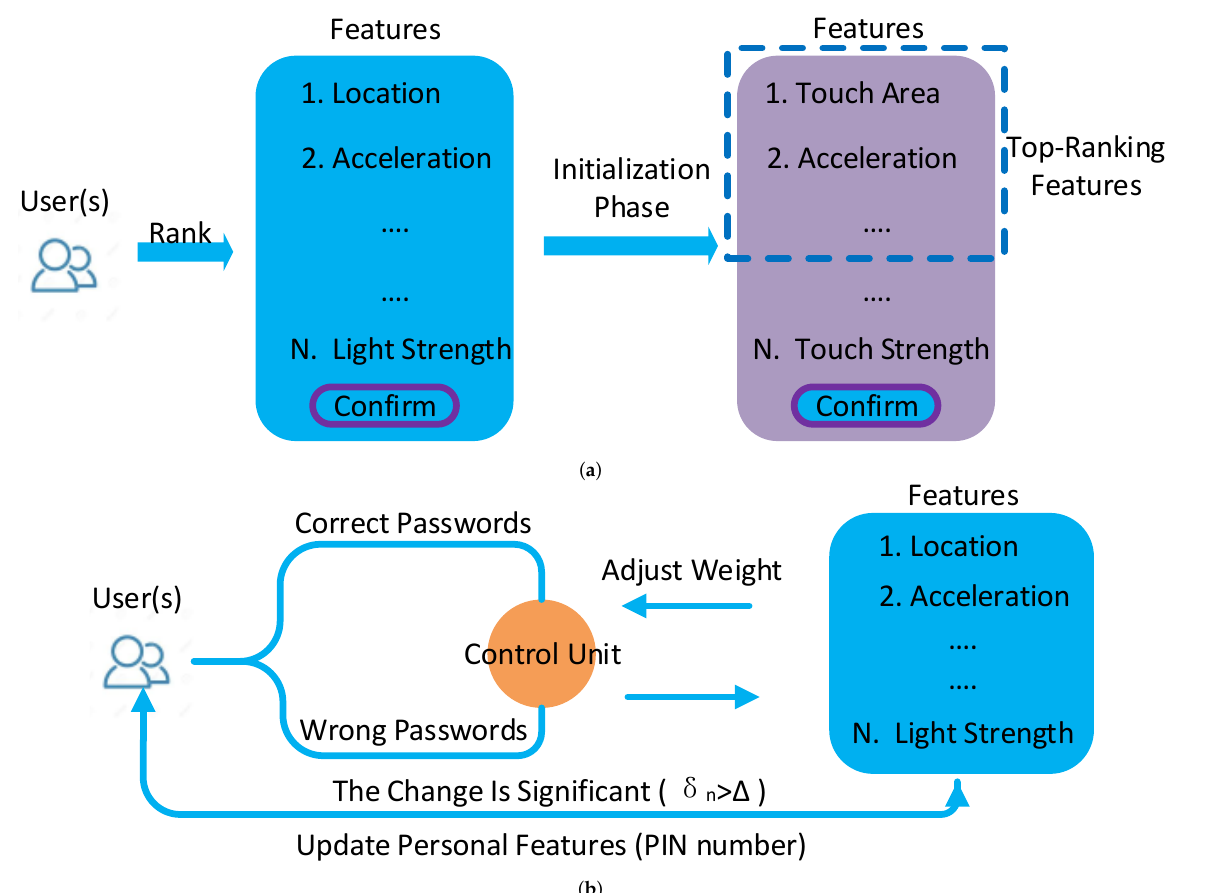
Figure 1. EchoIA overview. ( a ) The Initialization phase. ( b ) The Authentication